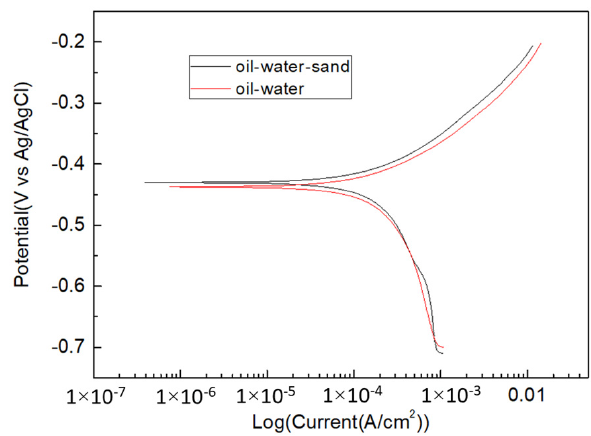
Figure 9. Tafel diagram measured in oil-water and oil-water-sand flow. Table 2. Weight loss and portion of the pure corrosion, pure erosion and